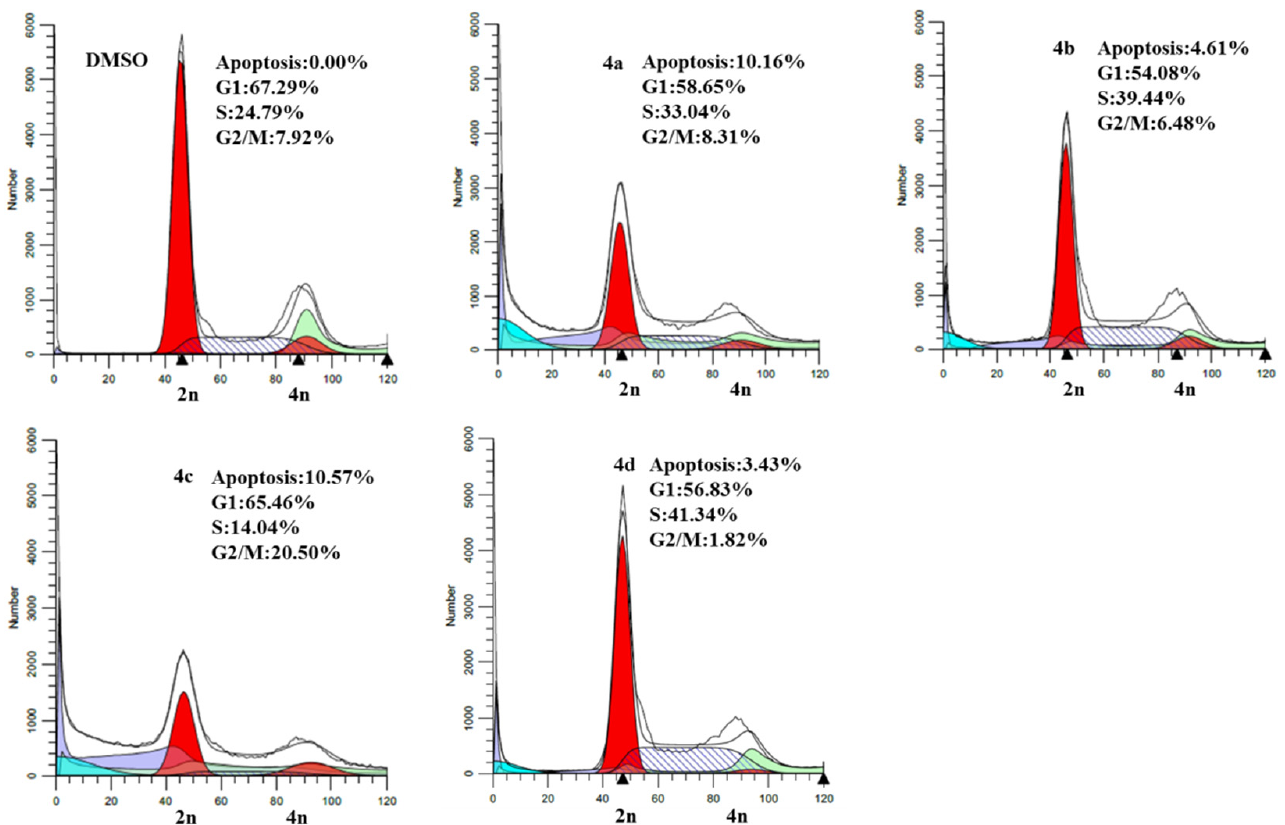
Figure 3. Nickel complexes inhibit cell cycle progression in LNCaP cells. LNCaP cells were treated with or without 5 μ M of chemicals and harvested for FACS analysis.